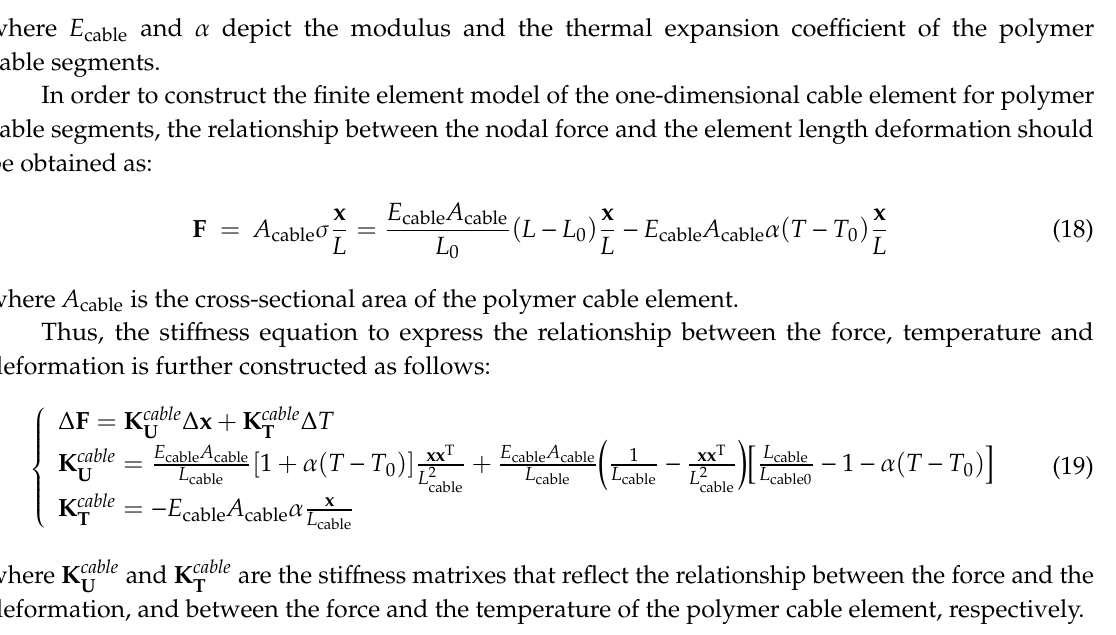
Figure 2. Comparison of σ s − T hysteresis between the simulation and that cited from [25].